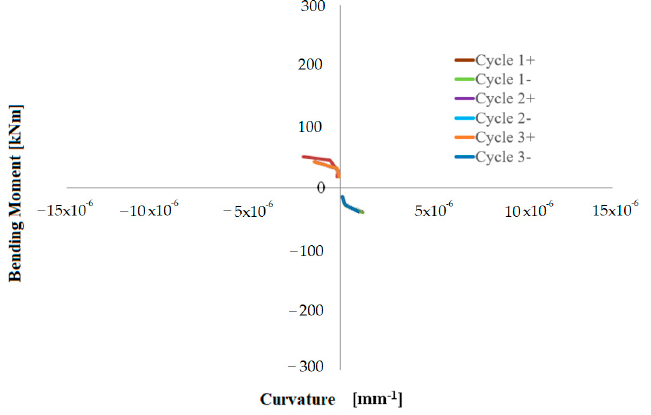
Figure 17. Bending moment-curvature diagram at the height of 1.26 m from the base– rectangular pier.